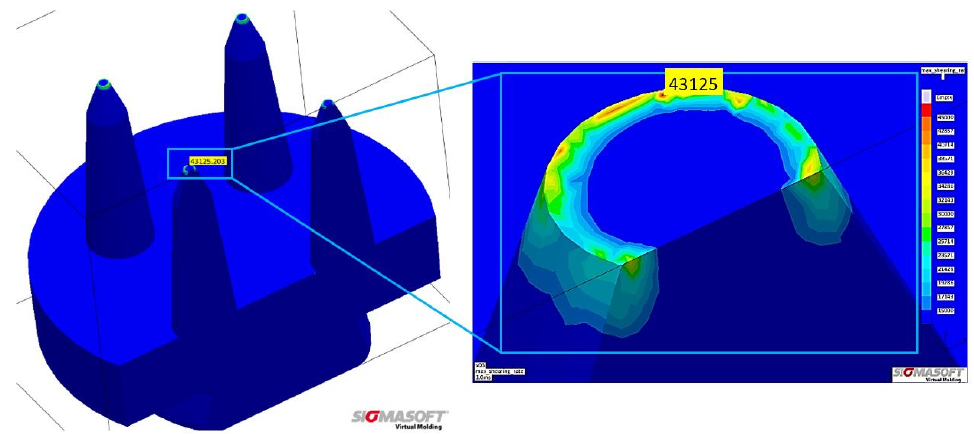
Figure 3. Simulated shear rate profile occurring at the gate (diameter 0.28 mm).